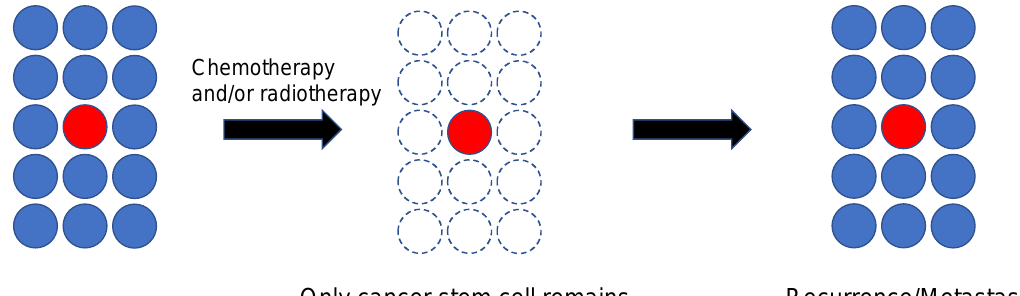
Figure 2. Schematic diagram of cancer stem cells responsible for recurrence/metastasis. Cancer stem cells are likely to remain after treatment because they are resistant to anti-cancer drugs or radiotherapy. They are considered to serve as a cause for recurrence/metastasis.